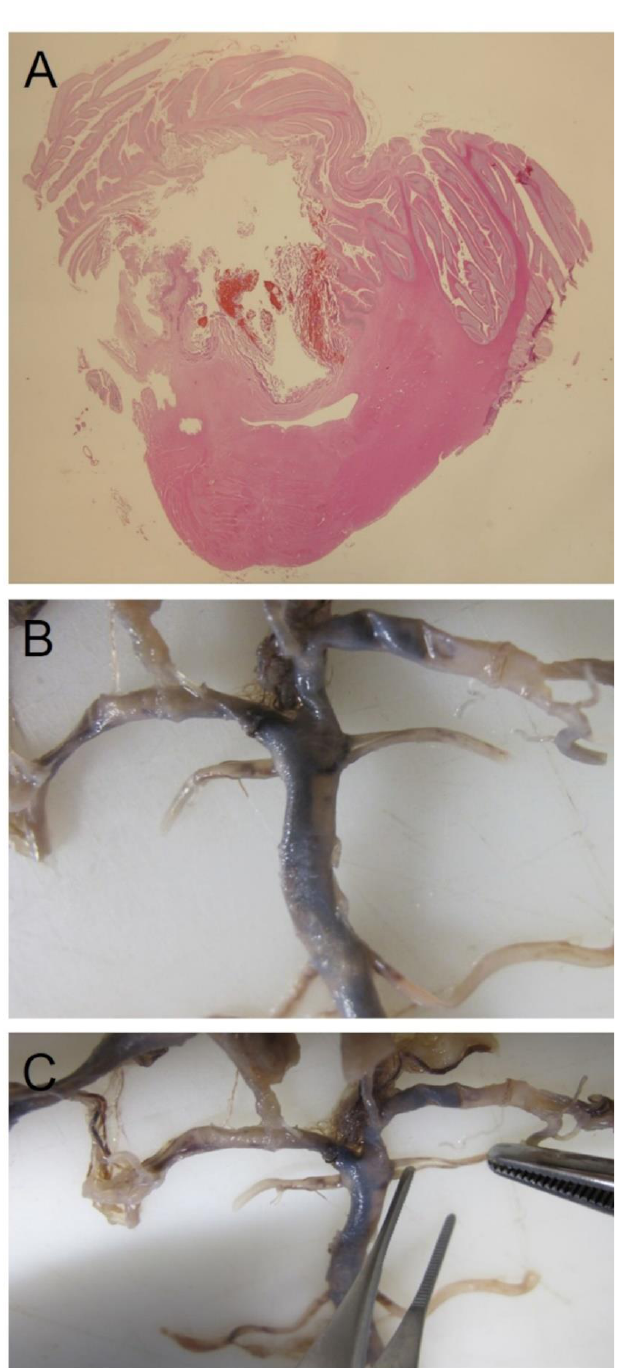
Figure 2. ( A ) Cerebellar macro-section showing hemorrhagic infarction in the vascular field of the superior cerebellar artery. ( B , C ) Double origin of the left superior cerebellar artery at macroscopic examination of the vessels of the brain.